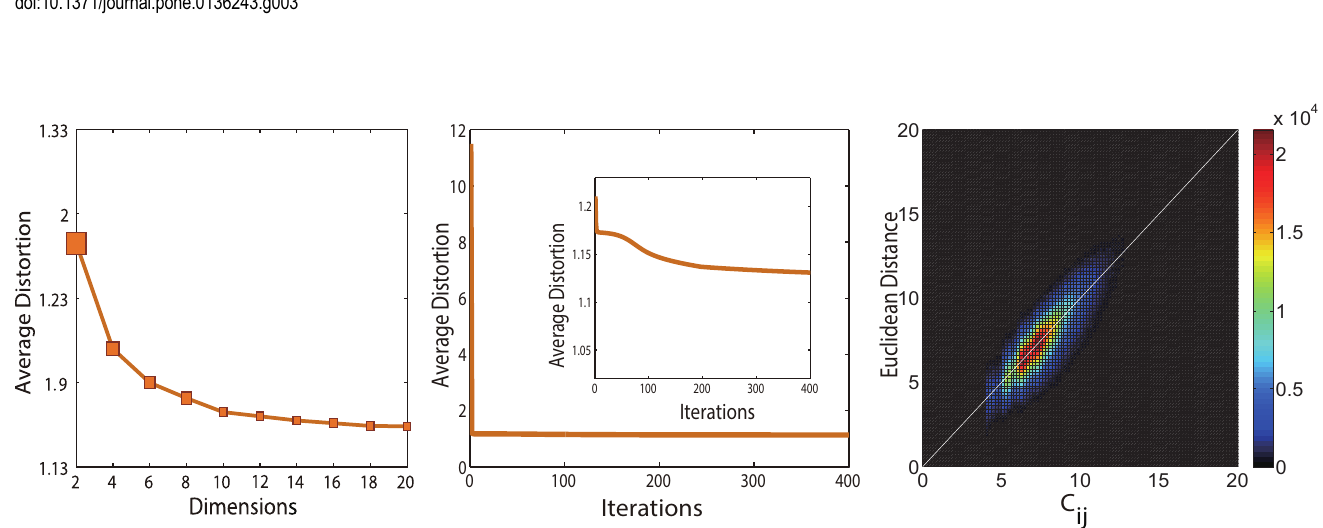
Fig 3. The geometric representation of top 2200 websites. Sub figure A shows the geometric representation of the selected websites on October 10 in 2006. The node colors represent the categories of the websites and the node sizes are proportional to the traffics of the focus websites. The small figures in the bottom are the same representations for selected Adults websites in B, Education websites in C, and News Recreation websites in D.